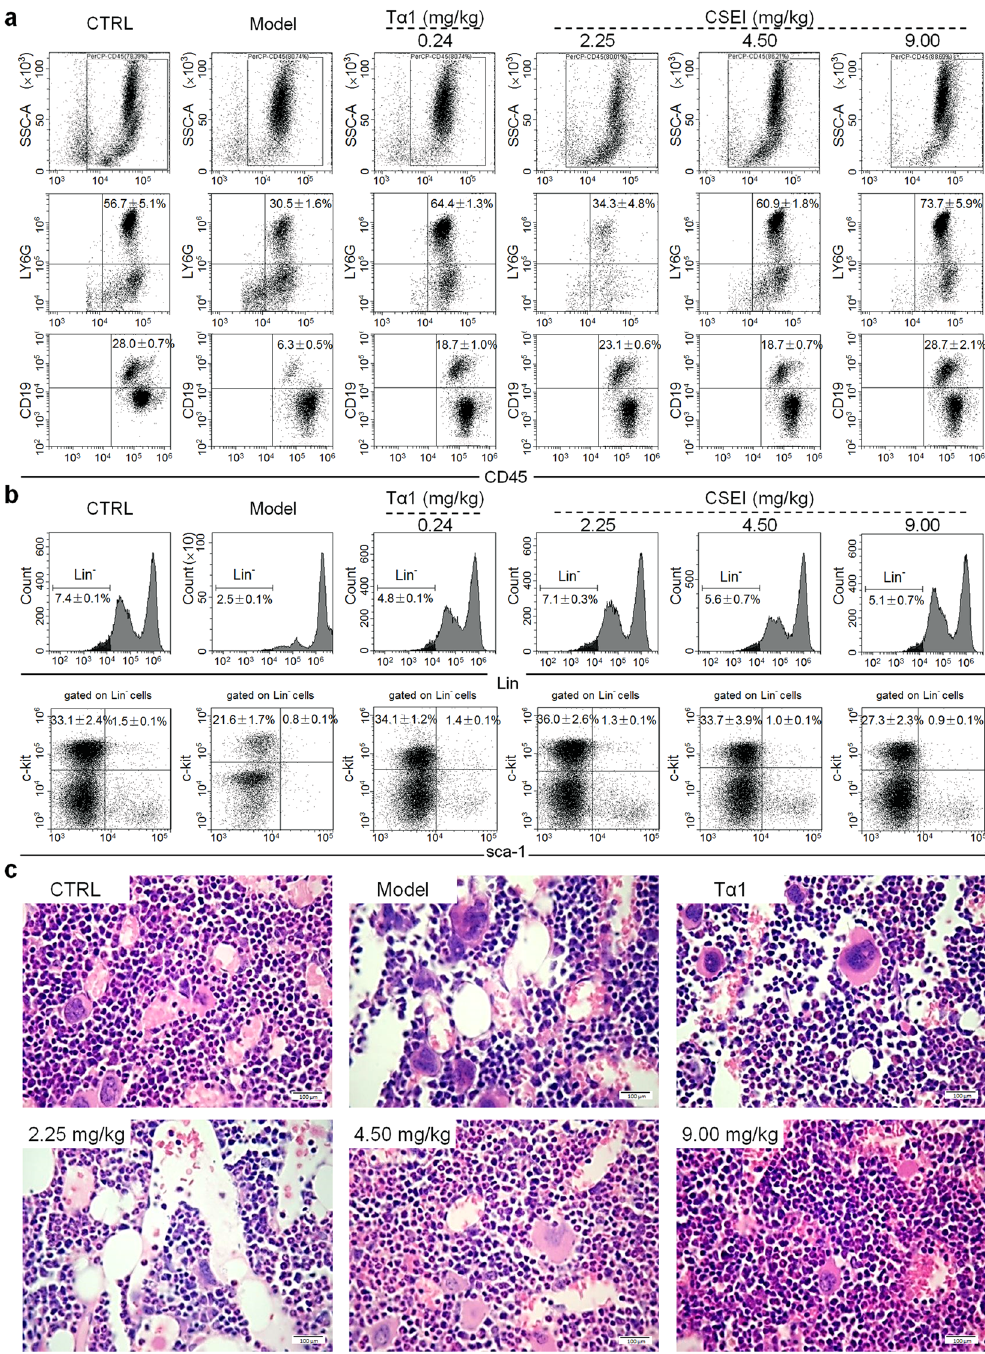
Figure 3. CSEI (2.25, 4.50 and 9.00 mg/kg) enhanced the CTX (100 mg/kg)-induced decrement of leukocyte, HSC/HPC and total bone marrow cellularity production in murine bone marrow of mice after 3-week administration. ( a ) Flow cytometry analysis of the proportion of leukocytes in murine bone marrow. CD45 was used for the sorting of leukocytes. CD45 + Ly6G + represents neutrophils and CD45 + CD19 + represents B cells. ( b ) The percentage of HSCs (Lin − c-kit + sca-1 + ) and HPCs (Lin − c-kit + sca-1 − ) in murine bone marrow of CTX-injected mice were analyzed by flow cytometry assay. ( c ) H&E staning of femurs were observed under a light-microscope digital camera (40 × , scale bar: 100 μ m) to evaluate the total bone marrow cellularity of bone marrow. The data are shown as the means ± S.E.M. (n =